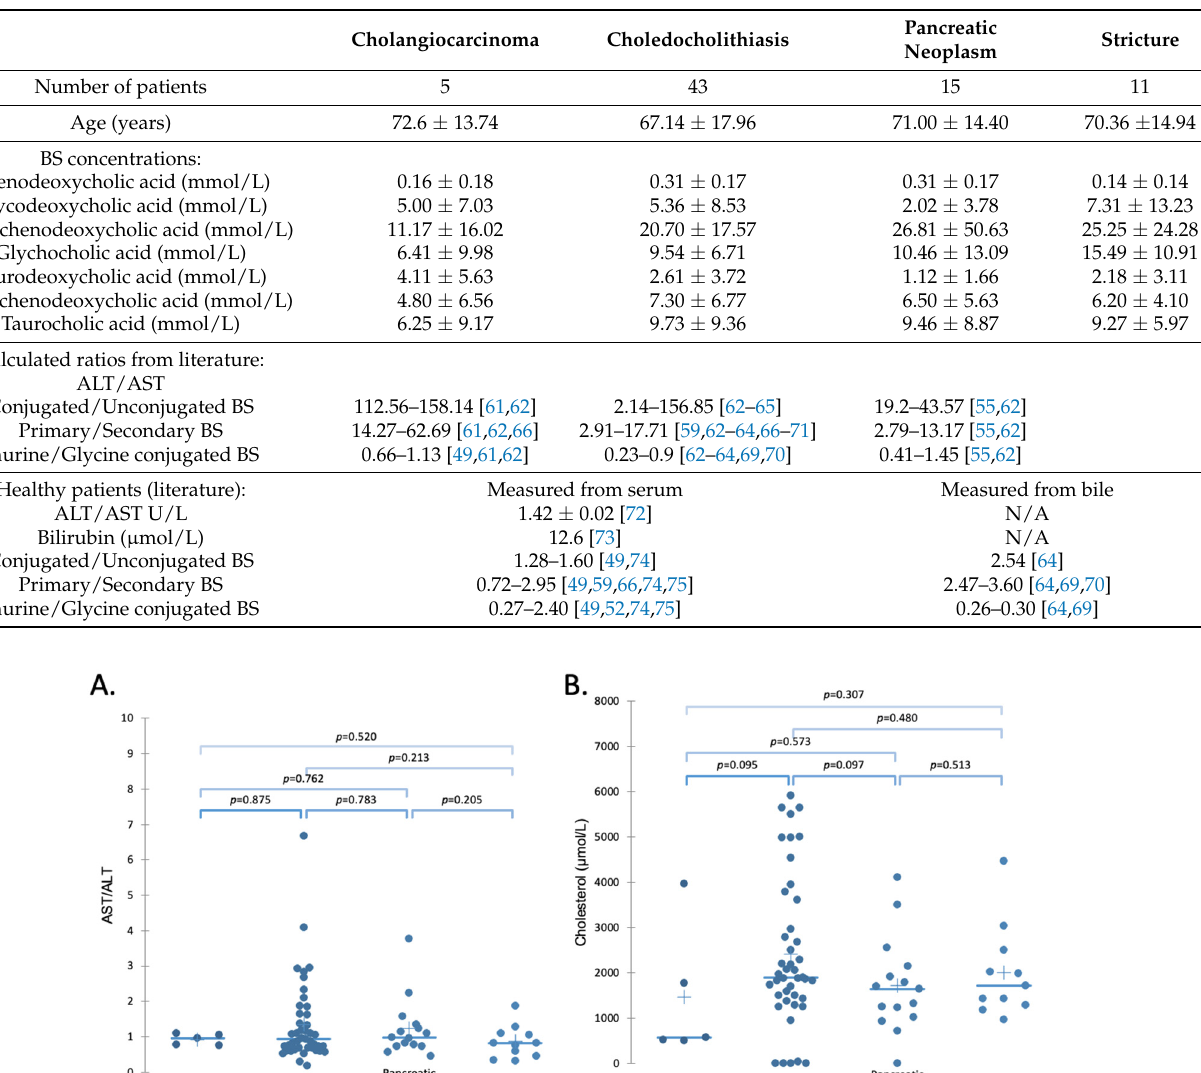
Table 1. Summary of the data from the 74 cases of biliary obstruction. Shown are the average levels of measured compounds with the standard deviation in each of the four classified pathologies. The ratios are calculated as a relative ratio, relative to the number of items. When comparing literature values of serum and bile levels, it was shown that the ratios of conjugated/unconjugated, primary/secondary, and taurine/glycine conjugated BSs did not differ between the serum of healthy patients and the collected bile of patients (with p values of 0.221, 0.053, and 0.355, respectively).